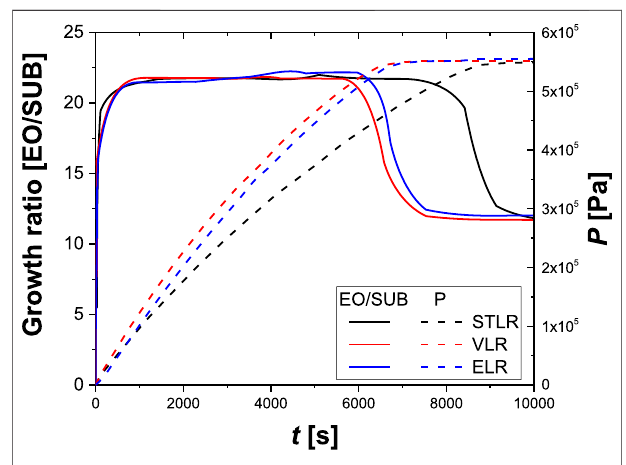
FIGURE 6| Calculated values ofgrowth ratio and total pressure, in VLR, STLR, ELR operating in the same conditions. Reactor volume: 20 m 3 ; total recirculating fl ow: 210 m 3 /h; maximum operating pressure: 5.5 bar; initial Nitrogen pressure: 1.2 bar; starter (dodecanol):500 kg; catalyst (KOH): 8 kg; exiting heat exchanger temperature: 178 ° C; fi nal growth ratio:20.5.